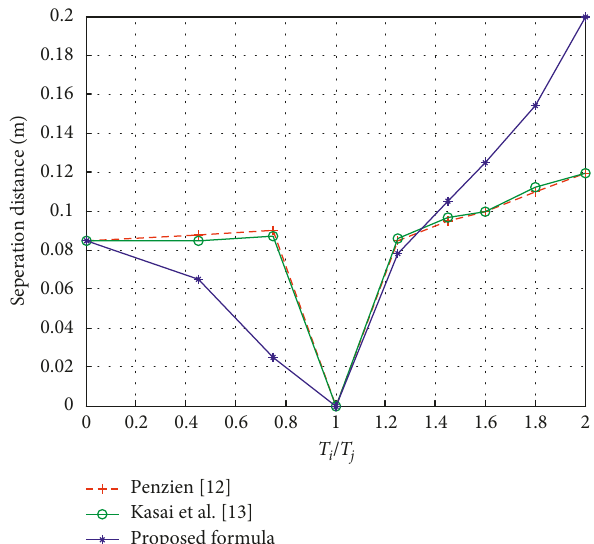
Figure 4: Minimum separation distance vs. ratio between effective periods of inelastic buildings.